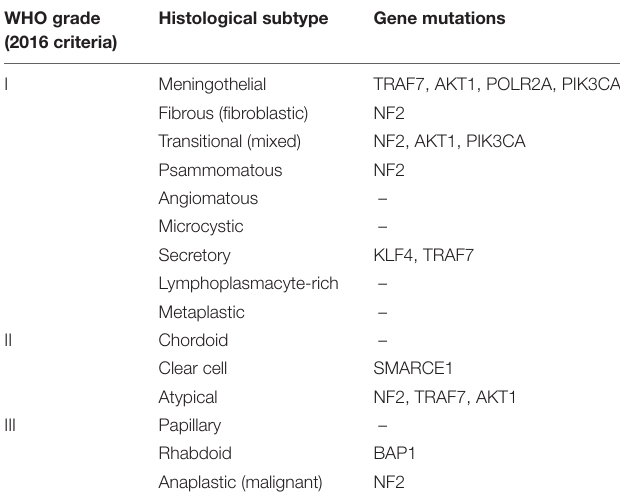
TABLE 2 | The WHO grade (2016 criteria)